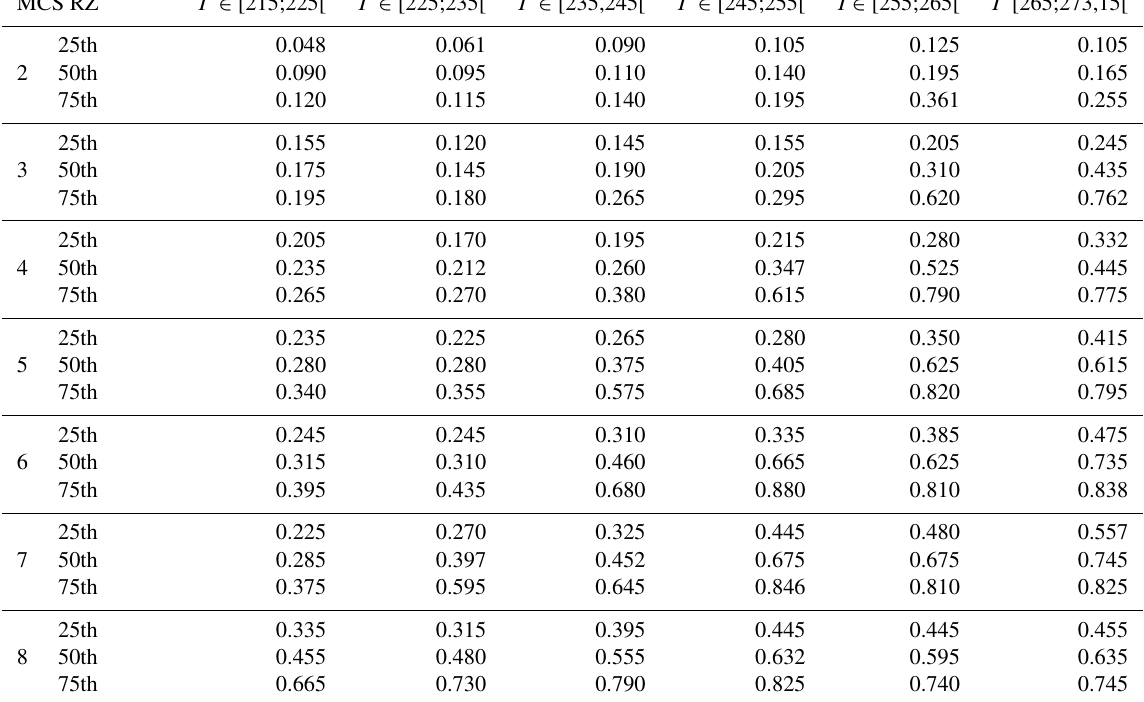
Table C9. The max (D max ) in cm (Fig.